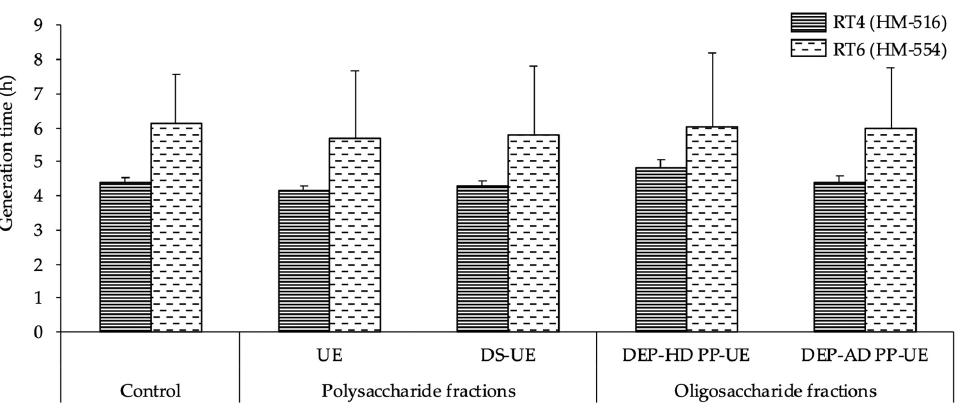
Figure 4 Figure 4. Effects of poly- and oligosaccharide Ulva sp. fractions at 1000 µ g/mL on the